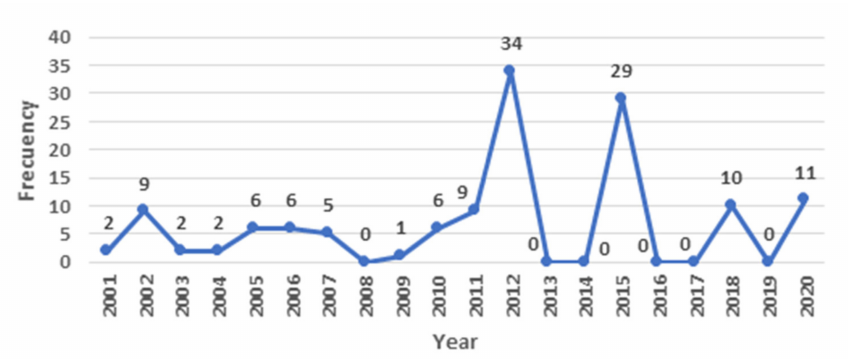
Figure 1. Designations of Magic Towns awarded by year. Source: own elaboration based on